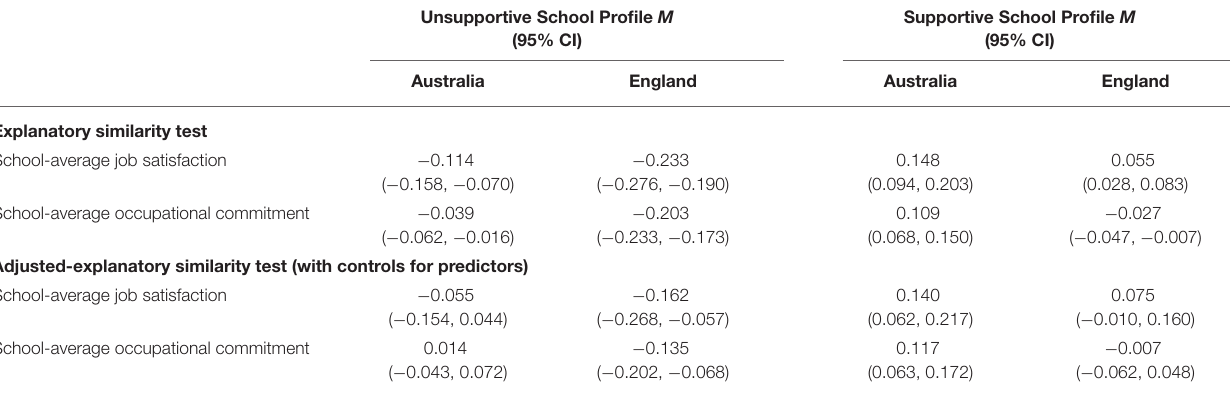
TABLE 7 | Means of school-level outcomes from explanatory similarity test and adjusted-explanatory similarity test (Multilevel LPA).